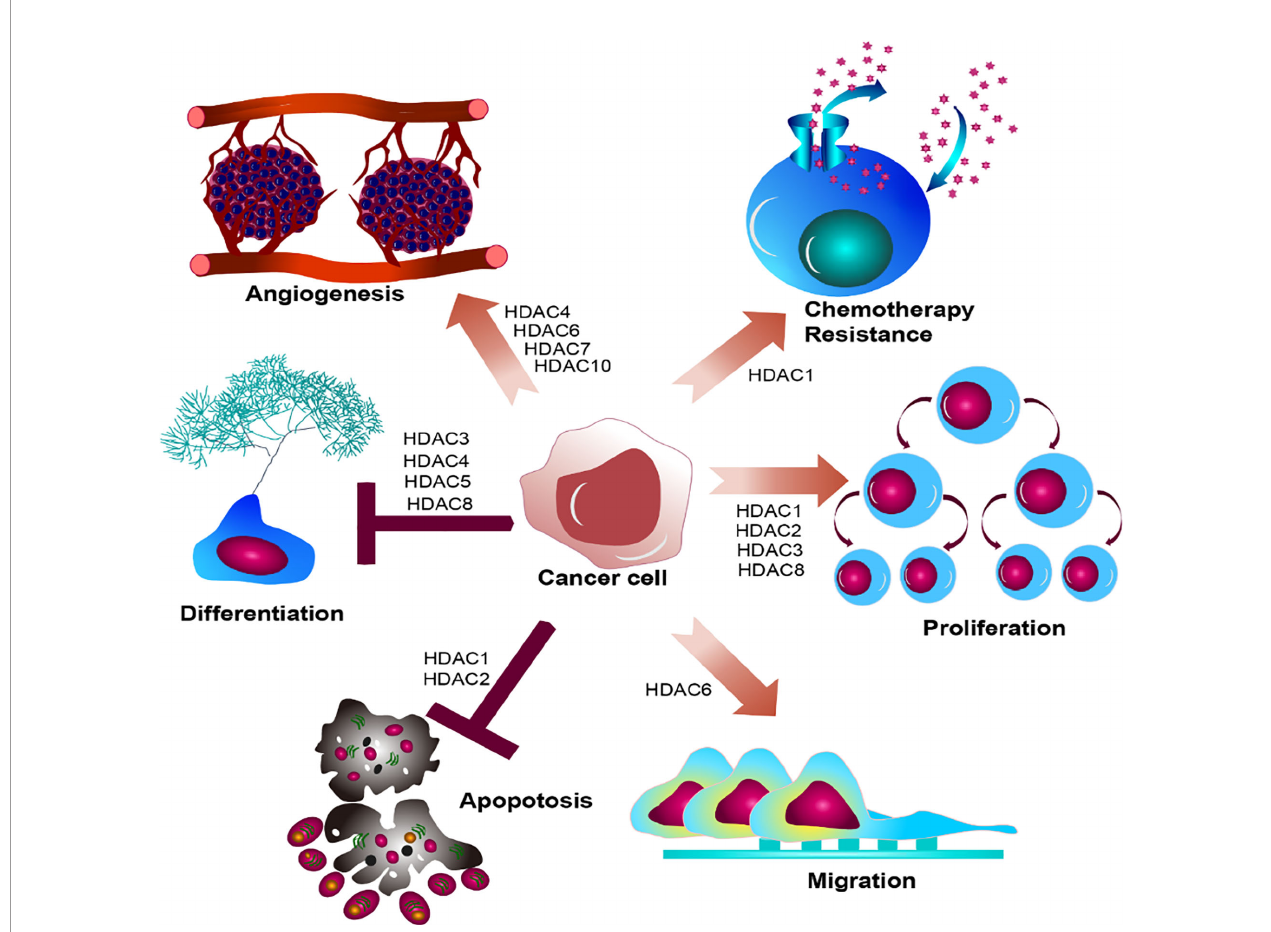
FIGURE 4 | Summary of HDACs functioning in cancer cell. HDAC family members determine biological effect of oncogenic hallmarks emerging in cancer cell, disrupting the regular cell development in cancer cell, leading to dysregulated differentiation, proliferation, migration, chemotherapy resistance, and